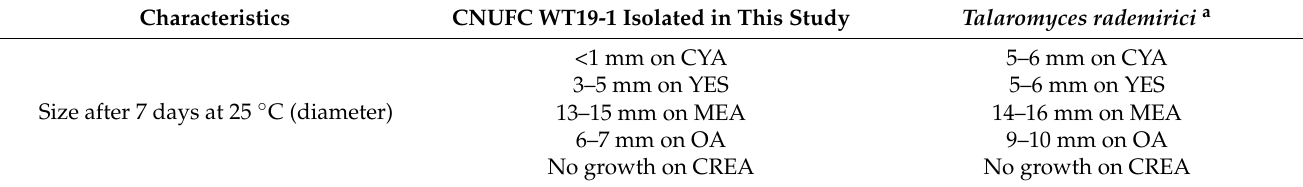
Figure 4. Morphology of Talaromyces gwangjuensis CNUFC WT19-1. ( A , E ) Colonies on Czapeck yeast autolysate agar (CYA). ( B , F ) Malt extract agar (MEA). ( C ) Yeast extract sucrose agar (YES). ( D ) Oatmeal agar (OA). ( G ) Dichloran 18% glycerol agar (DG 18). ( H ) Creatine sucrose agar (CREA). (( A – D , G , H ) Obverse view and ( E , F ) reverse view). ( I – L , N – Q ) Conidiophores. ( M , R ) Conidia. (( I – M ) LM and ( N – R ) SEM). Scale bars: ( I – M ) = 20 µ m, ( N – Q ) = 10 µ m, and ( R ) = 5 µ m. Table 2. Morphological characteristics of Talaromyces gwangjuensis CNUFC WT19-1 compared with those of the reference strain Talaromyces rademirici